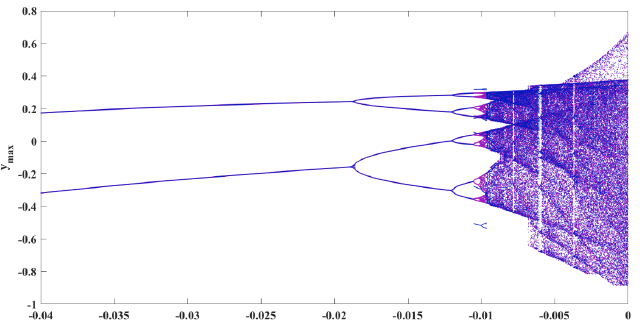
Figure 7. Bifurcation diagram of the oscillator by changing parameter a ; bifurcation with backward continuation method is shown in purple and with constant initial conditions is shown in blue.